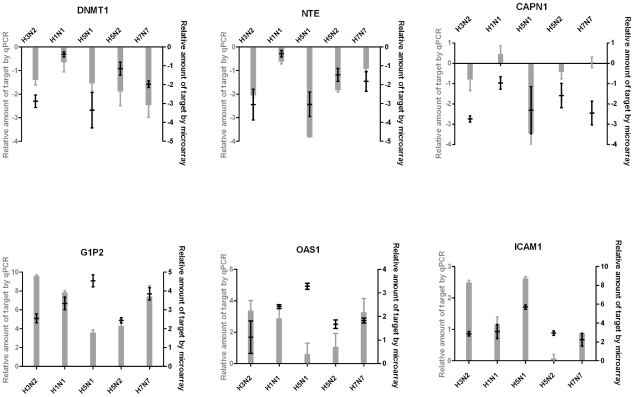
Validation of microarray results by real-time quantitative RT-PCR analysis.Expression of 6 genes from DNA microarray analysis (black cross) is compared with real-time quantitative PCR data (grey bar). Cross represent fold changes (mean ± S.D.) given by the microarray analysis  =  Log2 (normalized amount of target gene in infected samples) - Log2 (normalized amount of target gene in mock samples) (right). The formula used to determine the amount of target gene in infected cells by RT-qPCR, normalized to GAPDH and relative to mock is: 2−ΔΔCt where Ct is the threshold cycle and ΔΔCt  =  (Ct target infected – Ct gapdh infected) – (Ct target mock – Ct gapdh mock). Bar represented Log2 expression level (mean±S.D.) of target genes in two independent quantitative RT-PCR analysis (left).